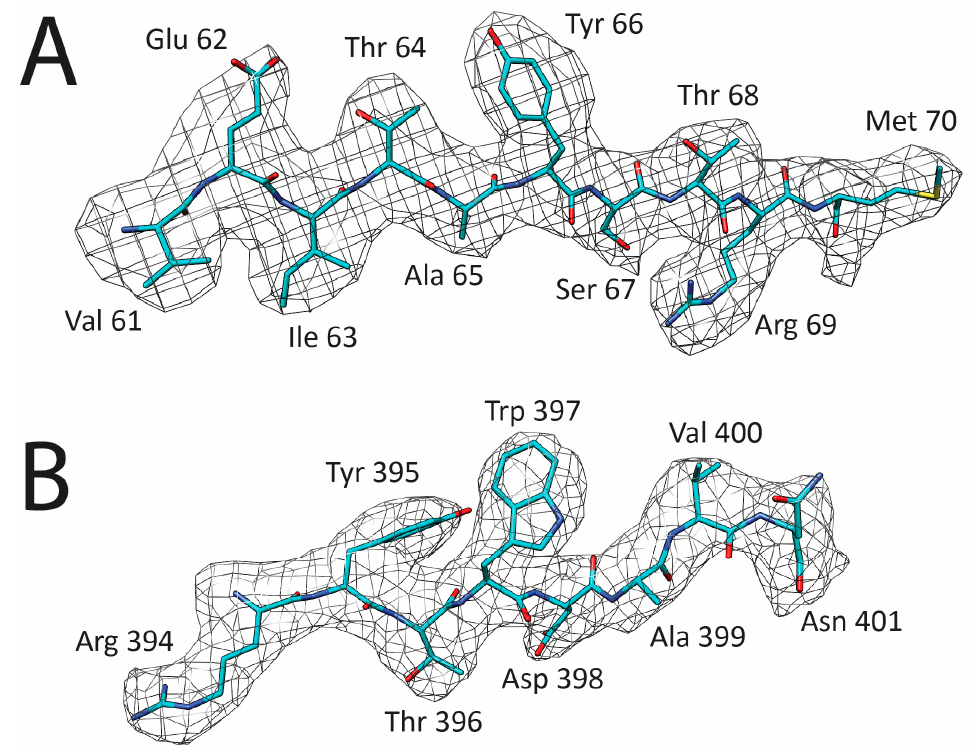
Figure 2. Representative density from the LuIII cryo-reconstruction. ( A ) Region from the β B strand located in the capsid core; ( B ) solvent exposed loop (394–401) on the capsid surface. Map density is in gray mesh (at σ = 1.0) and the LuIII model is in cyan. Residues are as labeled with atoms colored C = cyan, N = blue, O = red, S = yellow.